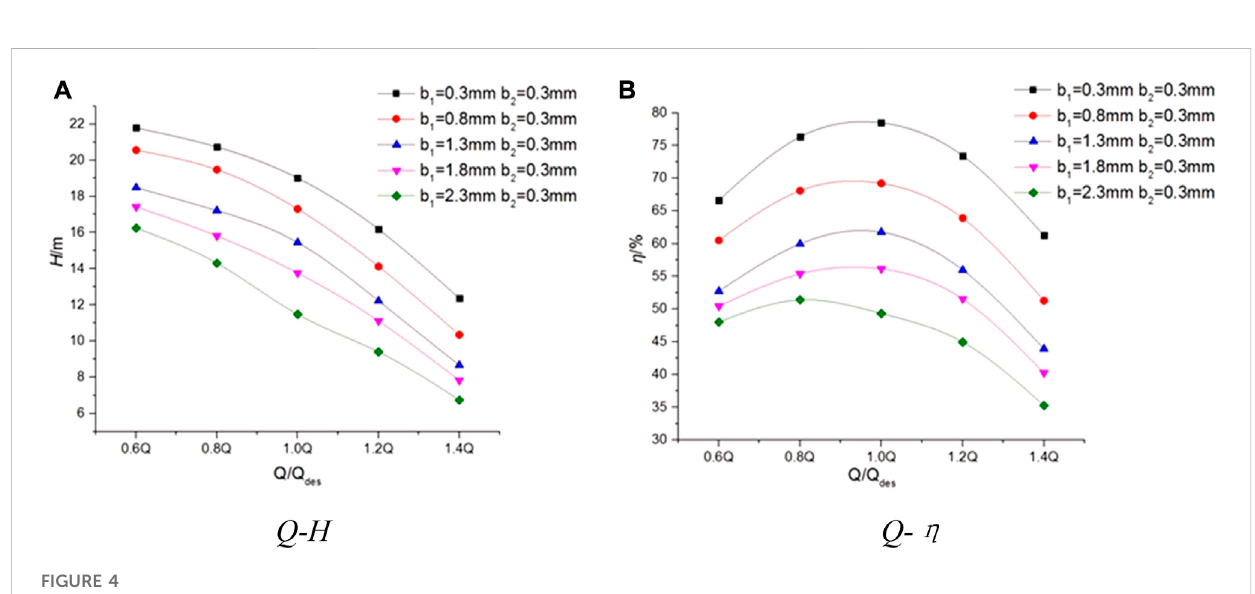
FIGURE 4 The performance curves of Scheme 1. (A) Q-H ; (B) Q- η